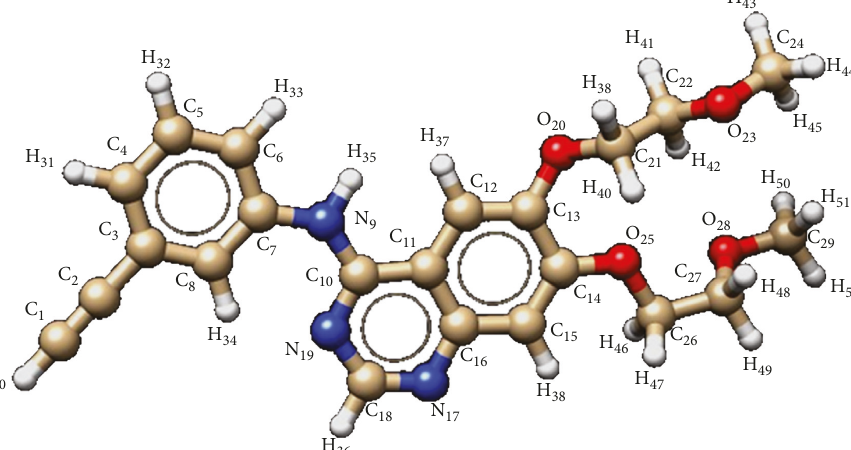
Figure 1: The optimized molecular structure of erlotinib drug [N-(3-ethynylphenyl)-6,7-bis (2-methoxyethoxy)-quinazolinamine